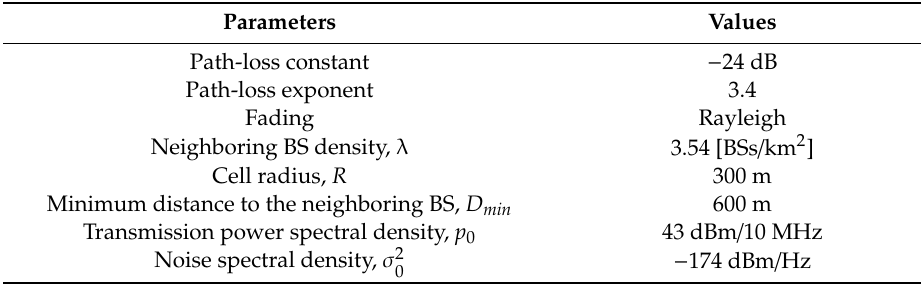
Table 1. Simulation